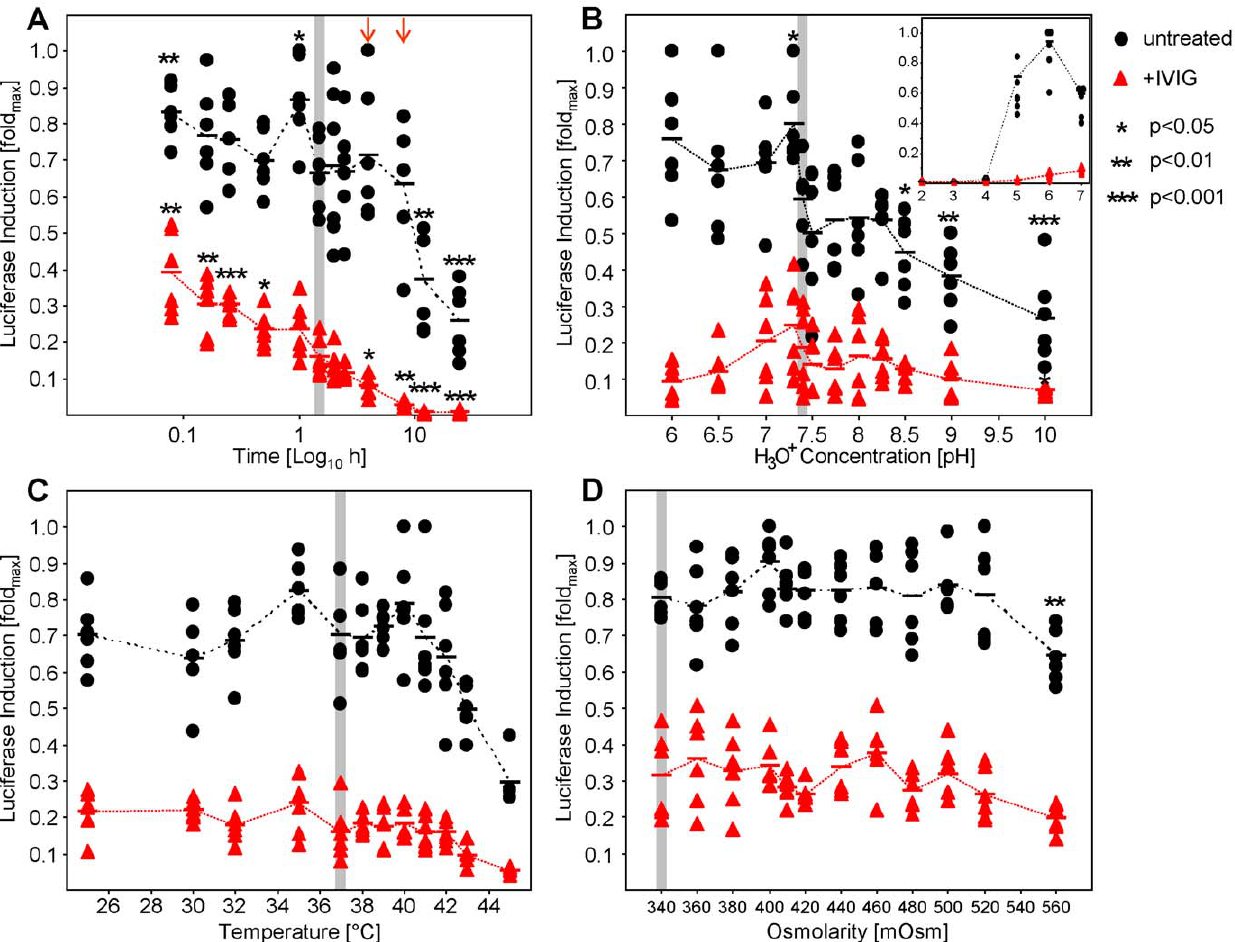
Figure 9. Neutralization test under different physicochemical parameters. MRC-5 cells were transiently transfected (nucleofection) with pTA-Control plasmid. 3 PFU/cell HCMV-TB40/E were incubated for 90 min at 37 u C (or as indicated otherwise) with a 1/40 dilution of IVIG Cytotect H (red triangles) or antibody-free medium (black dots). After this incubation MRC-5 cells were infected. Luciferase induction was assessed one day post infection. Results are depicted as fold response compared to maximum response to allow comparison of the six independent experiments. ( A ) Effect of virus-antibody incubation time. ( B ) Impact of acidity (pH) on neutralization. Media was buffered to the indicated pH value by addition of HCl or NaOH, respectively. Arrows indicate time points (4 and 8 h) where intrinsic stability is not affected but neutralization is enhanced. An insert shows the neutralization at acidic conditions (pH 2–7). ( C ) Impact of temperature on neutralization during virus-antibody incubation. ( D ) Grading increase in osmolarity (by addition of NaCl; whereby 1 mM NaCl was calculated as 2 mOsm due to dissociation of ions) on neutralization. Standard conditions are shaded in grey. Statistically significant (two-tailed paired t-test) differences from these conditions are indicated by asterisks.